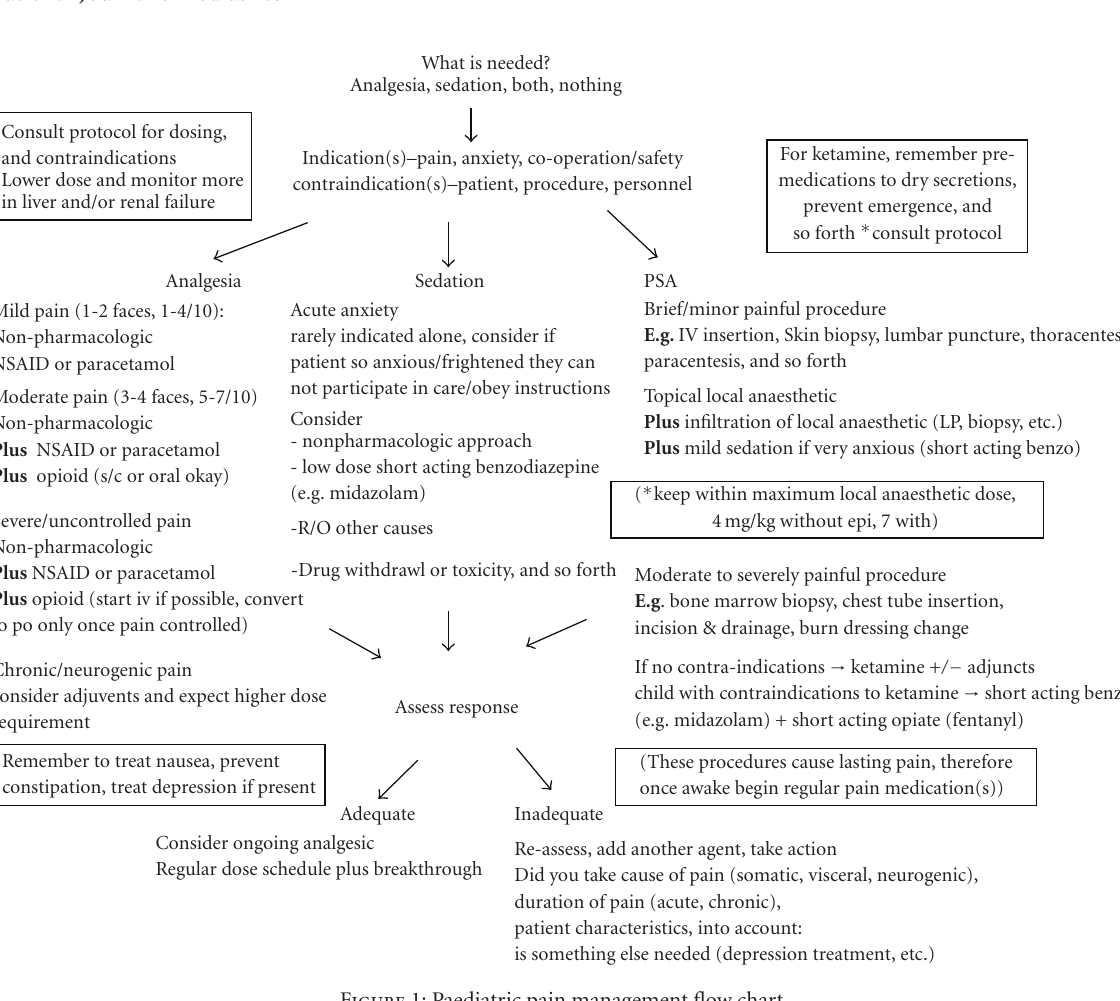
Figure 1: Paediatric pain management flow